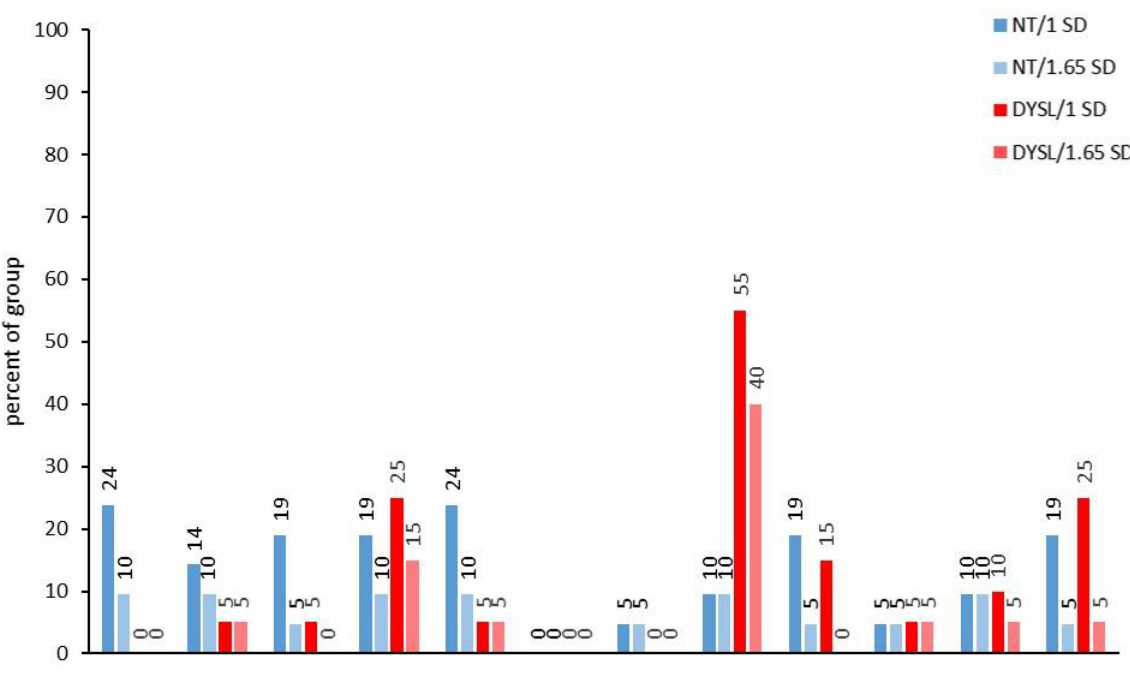
Figure 4. Deviating performance/visual subtests. NT: neurotypical normal reading children, DYSL: children with dyslexia, rct: reaction time, err: errors, MG: moving gratings, CM: coherent motion, CC: coherent color, PS: pattern sequence, StG: stationary gratings, Ro: mental rotation.